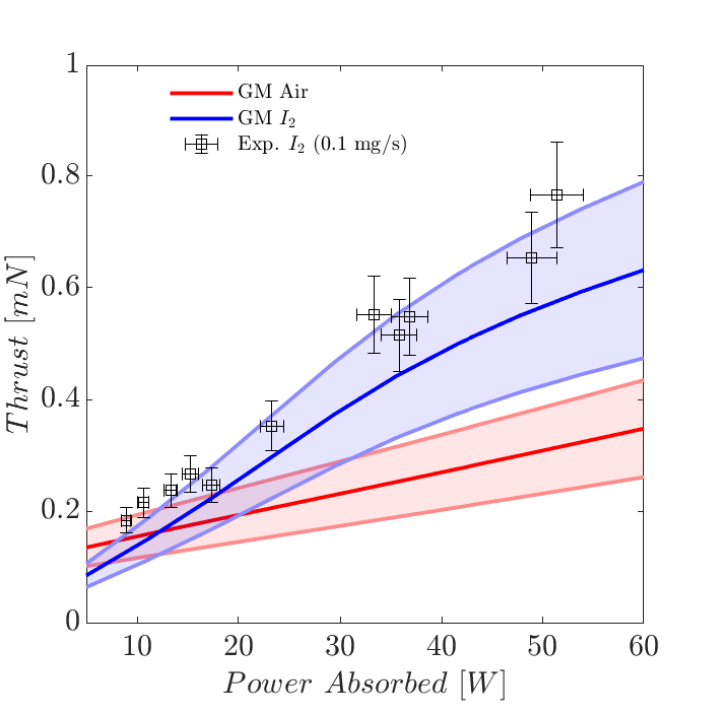
Figure 3. Comparison of thrust estimated from the GM against experimental measures of a laboratory model of ambipolar thruster as a function of